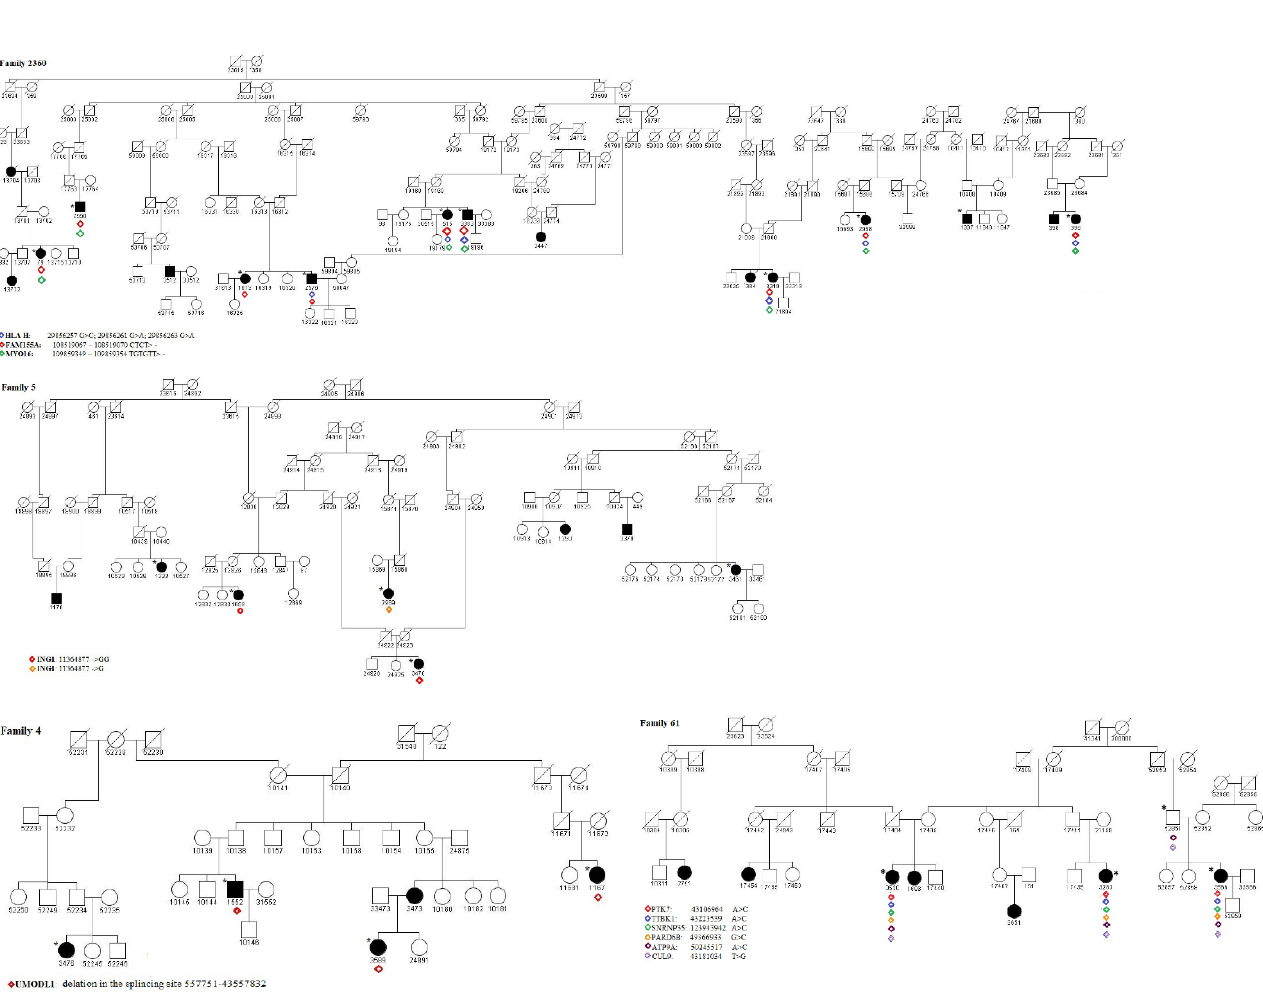
Figure 2. Pedigree of families in the study. Squares and circles indicate men and women, respectively. The symbols in black represent the affected members. The squares or circles with a line indicate a deceased individual. The asterisk represents subjects in the pedigree for which WES data were available, while the colored triangles indicate the subjects carrying the variant.